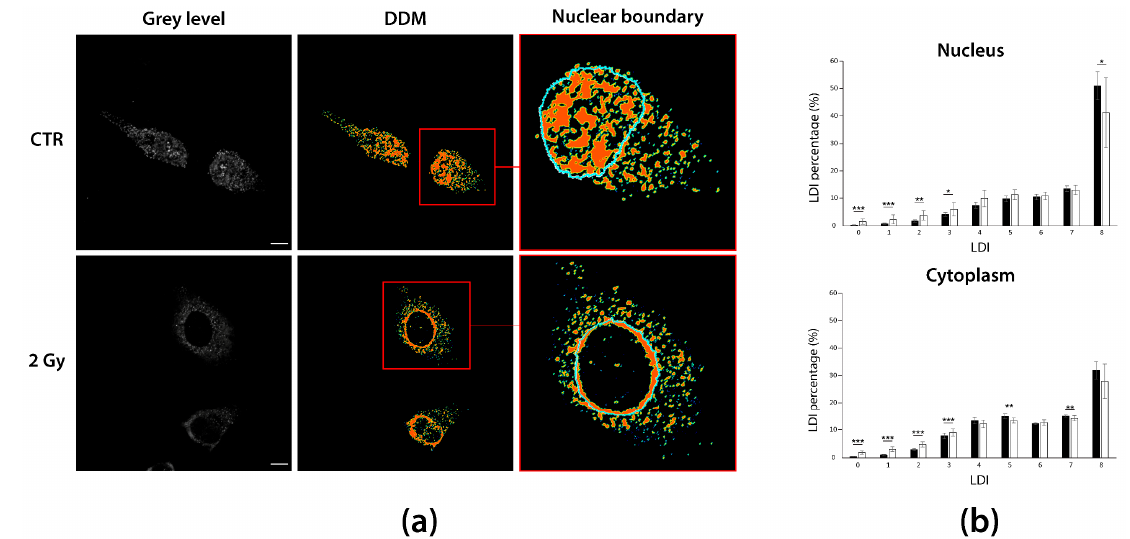
Figure 5. DDMs can capture relevant spatial distributions blind to visual inspection. ( a ) Grey level images of untreated and 2-Gy irradiated A549 sh/p53 cells are used to compute DDMs for immunostained RNA:DNA hybrids. DDMs highlight a perinuclear hybrids crowding inside the nucleus of 2-Gy irradiated cells. ( b ) Bar graphs of LDI percentages in the main cell compartments. A549 sh/p53 2-Gy irradiation induces hybrids de-condensation in both nucleus and cytoplasm, although with a slightly different magnitude. * p < 0.05; ** p < 0.01; *** p < 0.001. Scale bars: 10 µm.